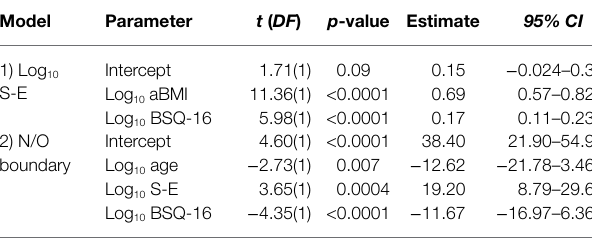
TABLE 4 | Outputs from the multiple regression